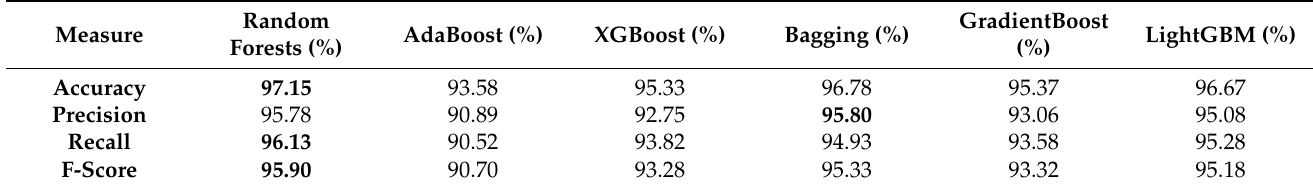
Table 4. Performance of ensemble classifiers for Dataset